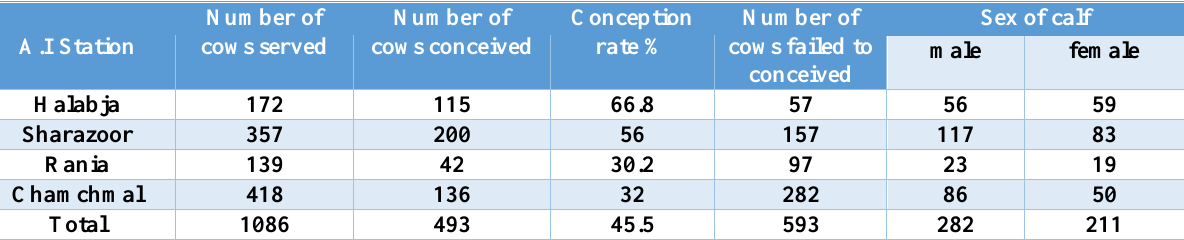
Table, 1: The conception rate of cows and calf sex in different AI stations of Sulaimani